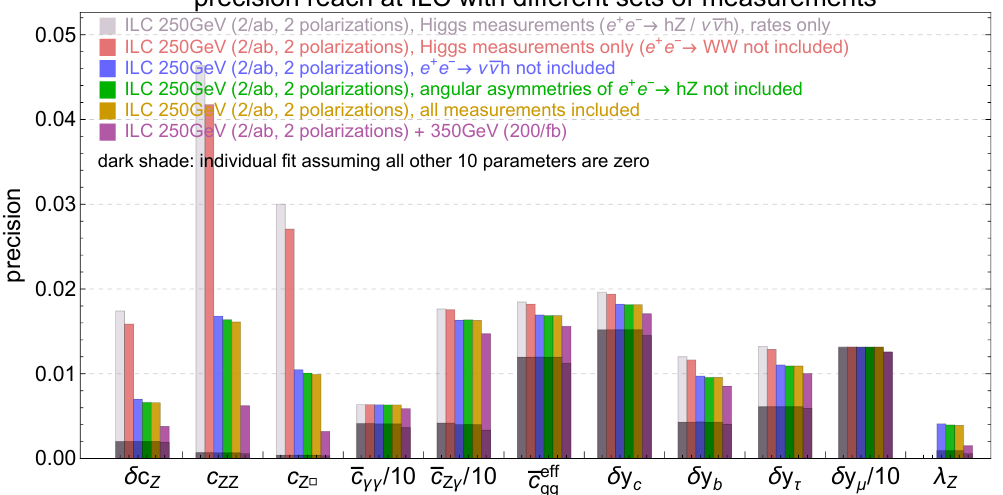
Figure 19 . Same as (cid:12)gure 8 but for ILC with 2 ab (cid:0) 1 at 250 GeV and 200 fb (cid:0) 1 at 350 GeV. The 250 GeV run is divided into two runs with polarizations P ( e and fractions 0 : 7 and 0 : 3, respectively (see (cid:12)gure